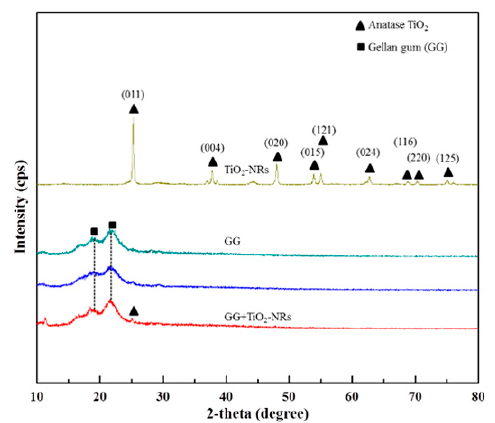
-NRs, GG, and GG+TiO 2